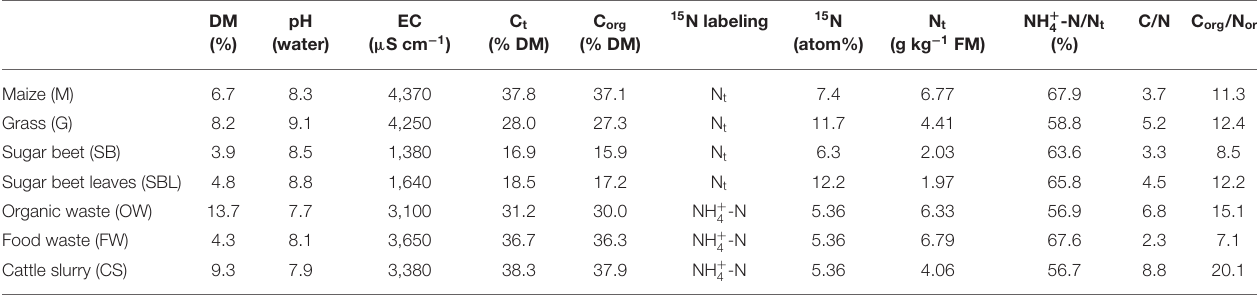
TABLE 1 | Physico-chemical digestate properties, 15 N-labeling and 15 N abundance.